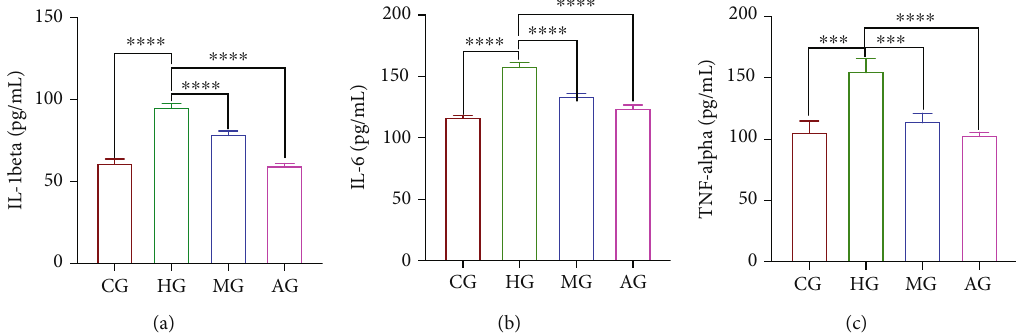
Figure 7: The levels of in fl ammatory cytokines. (a) IL-1 β . (b) IL-6. (c) TNF- α . n = 3 for each group, and ns P > 0 : 05 and ∗∗∗∗ P < 0 : 0001 vs. the HG group.